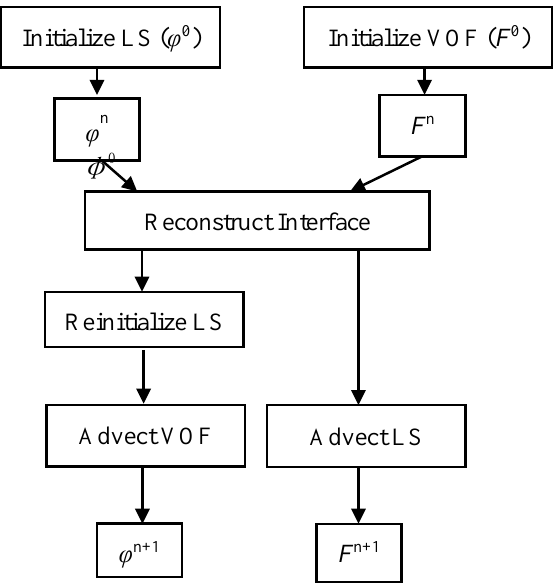
Figure 2. The flowchart of the CLSVOF method.